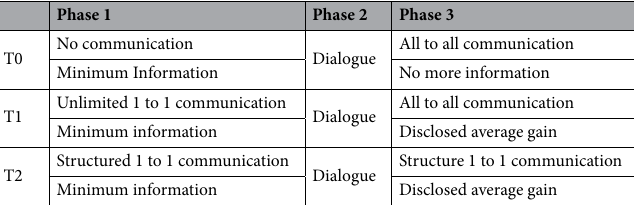
Table 1. Communication and information conditions in the three treatments by